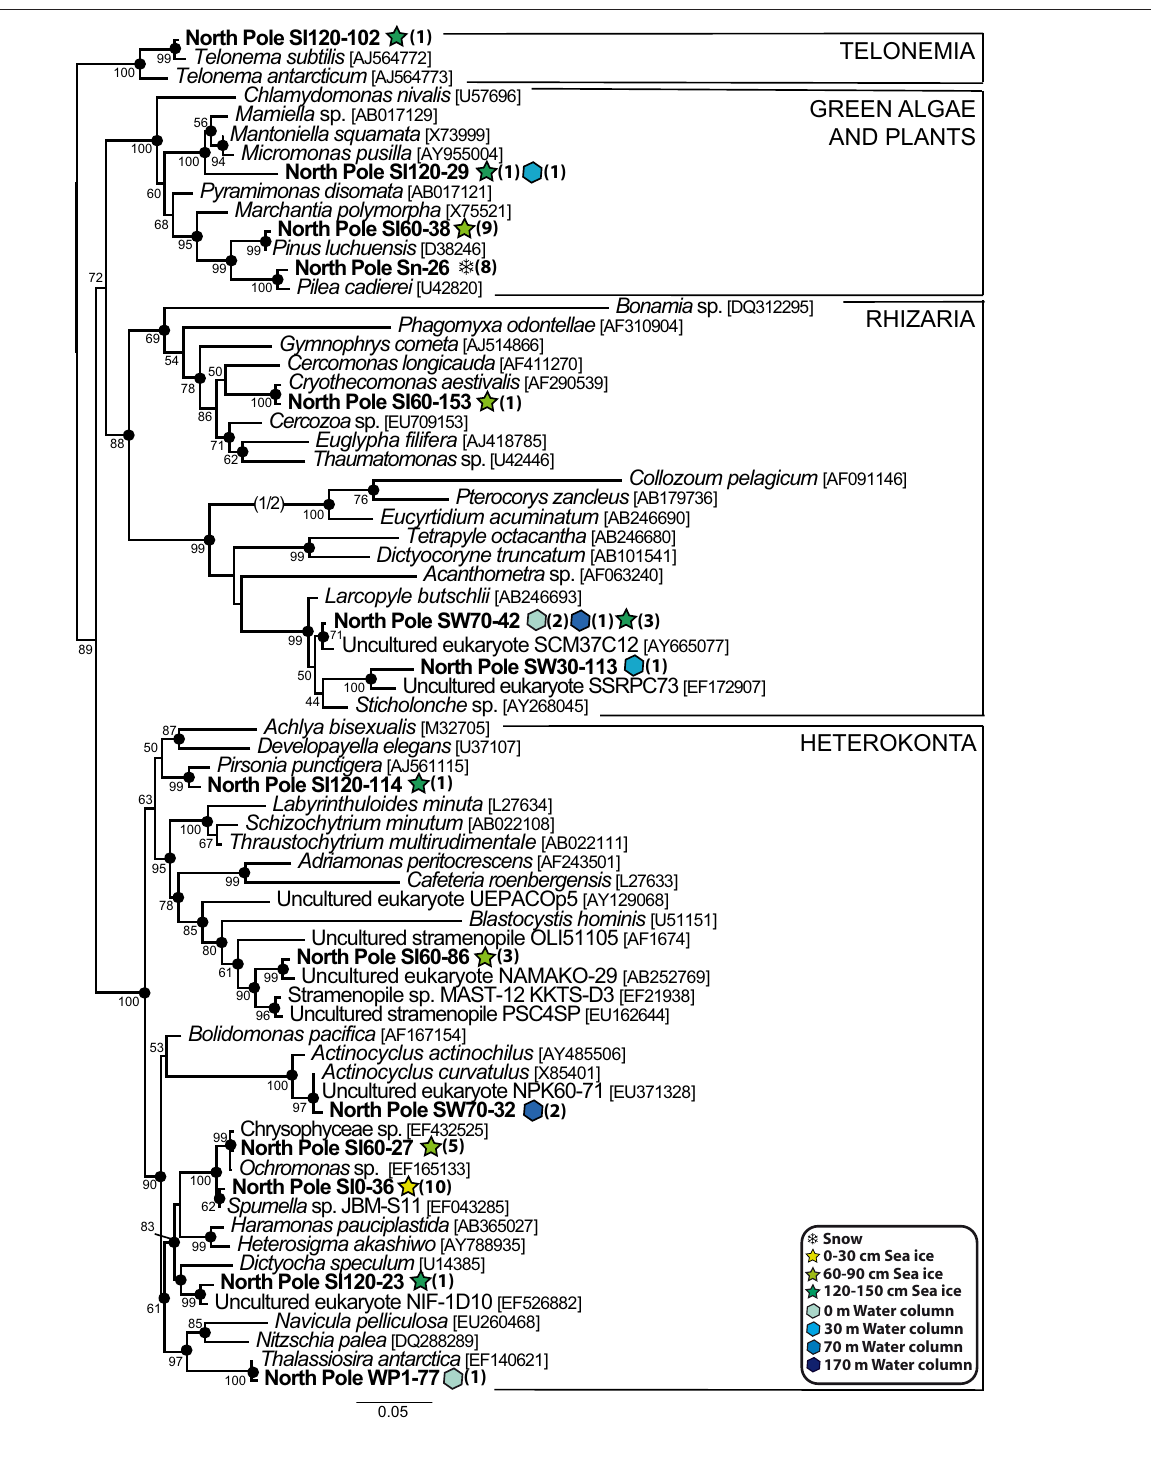
related to Myrionecta rubra and Strombidium conicum , which possess plasts obtained from partial digestion of algal prey (Gustafson et al., 2000; Johnson and Stoecker, 2005;